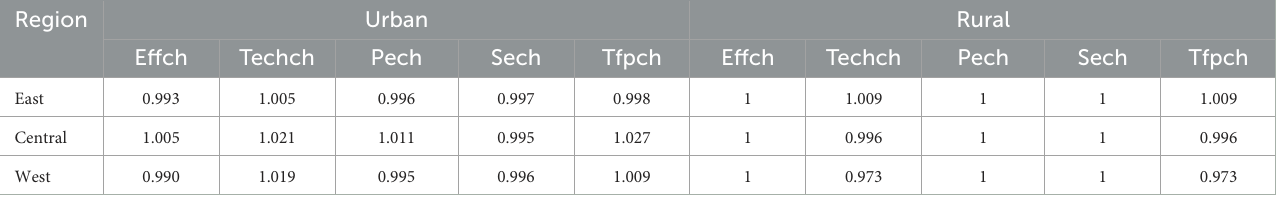
TABLE 6 The Malmquist index and its decomposition for PHCIs at the regional level, 2009-2019. Region Urban